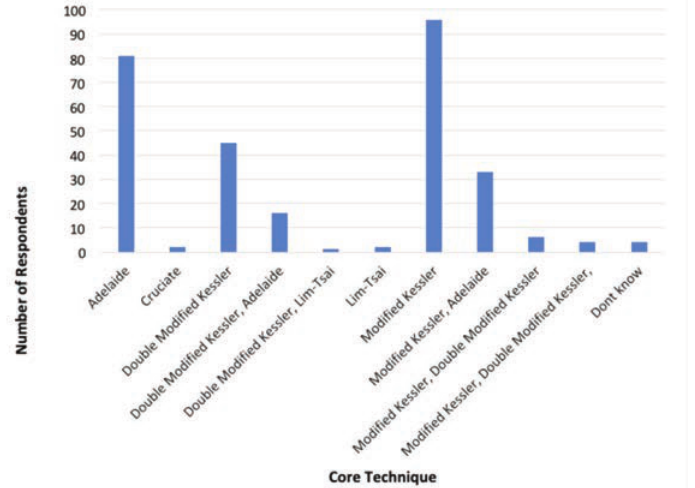
Preferred core technique of respondents in flexor tendon repair. Fig. 1: